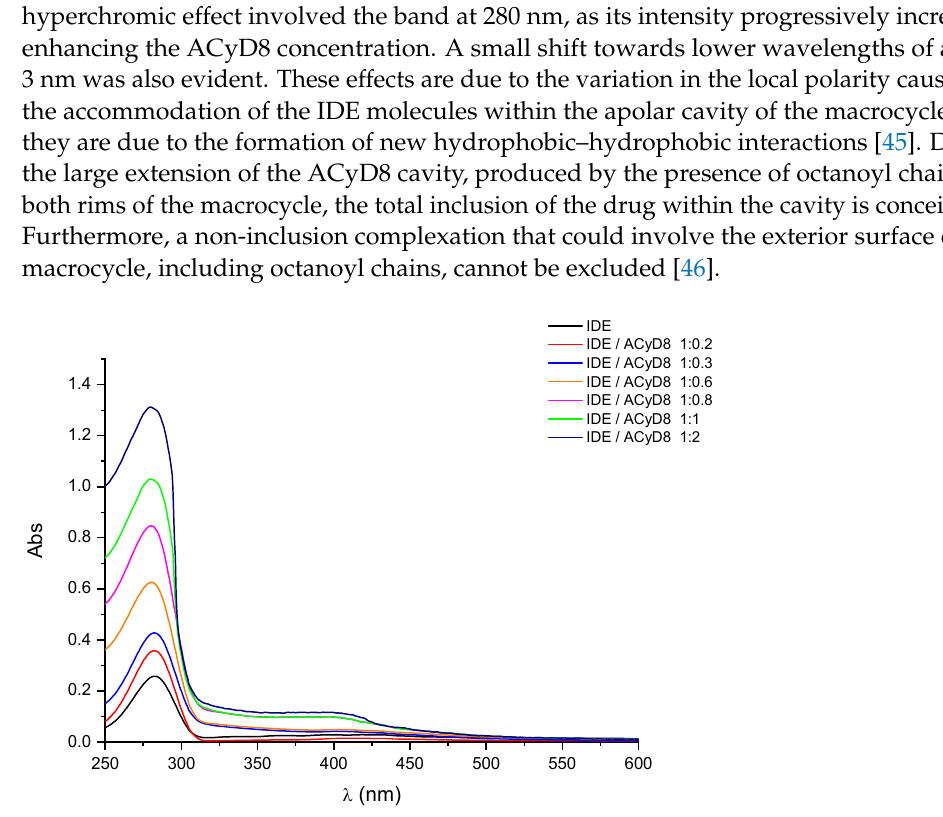
Figure 2. UV-vis spectra of IDE in the presence of increasing concentration of ACyD8. See Experi- mental Section for details. UV-vis data were used to determine the apparent binding constant (Kc) of the 1:1 IDE/ACyD8 inclusion complex on the basis of the Benesi–Hildebrand equation [45]. A lin- ear relationship (R 2 = 0.9882) was obtained for the plot of 1/A-A 0 versus 1/[ACyD8] (Figure 3), but not for the plot of 1/A-A 0 versus 1/[ACyD8] 2 (R 2 = 0.9676) (plot not shown) demon- strating the presence in solution of a 1:1 inclusion complex. The Kc value determined by the ratio of the intercept on the slope was 19.698 × 10 3 M −1 , pointing out a high affinity of IDE for the amphiphilic macrocycle. Figure 3. The Benesi–Hildebrand plot of 1/A-A 0 vs. 1/[ACyD8] obtained from UV-vis data. 2.1.2. NMR Studies With the aim to study the supramolecular interaction and binding sites between IDE and ACyD8, 1 H NMR studies and 2D-ROESY experiments were performed (Figures 4 and 5). NMR spectroscopy is one of the most useful tools for a structural analysis of the host/guest interaction, providing useful information on supramolecular systems. Figure 4 shows a comparison between the 1 H NMR spectrum of the free drug (blue trace), ACyD8 (red trace) and the IDE/ACyD8 inclusion complex (green trace). The IDE/ACyD8 inclusion